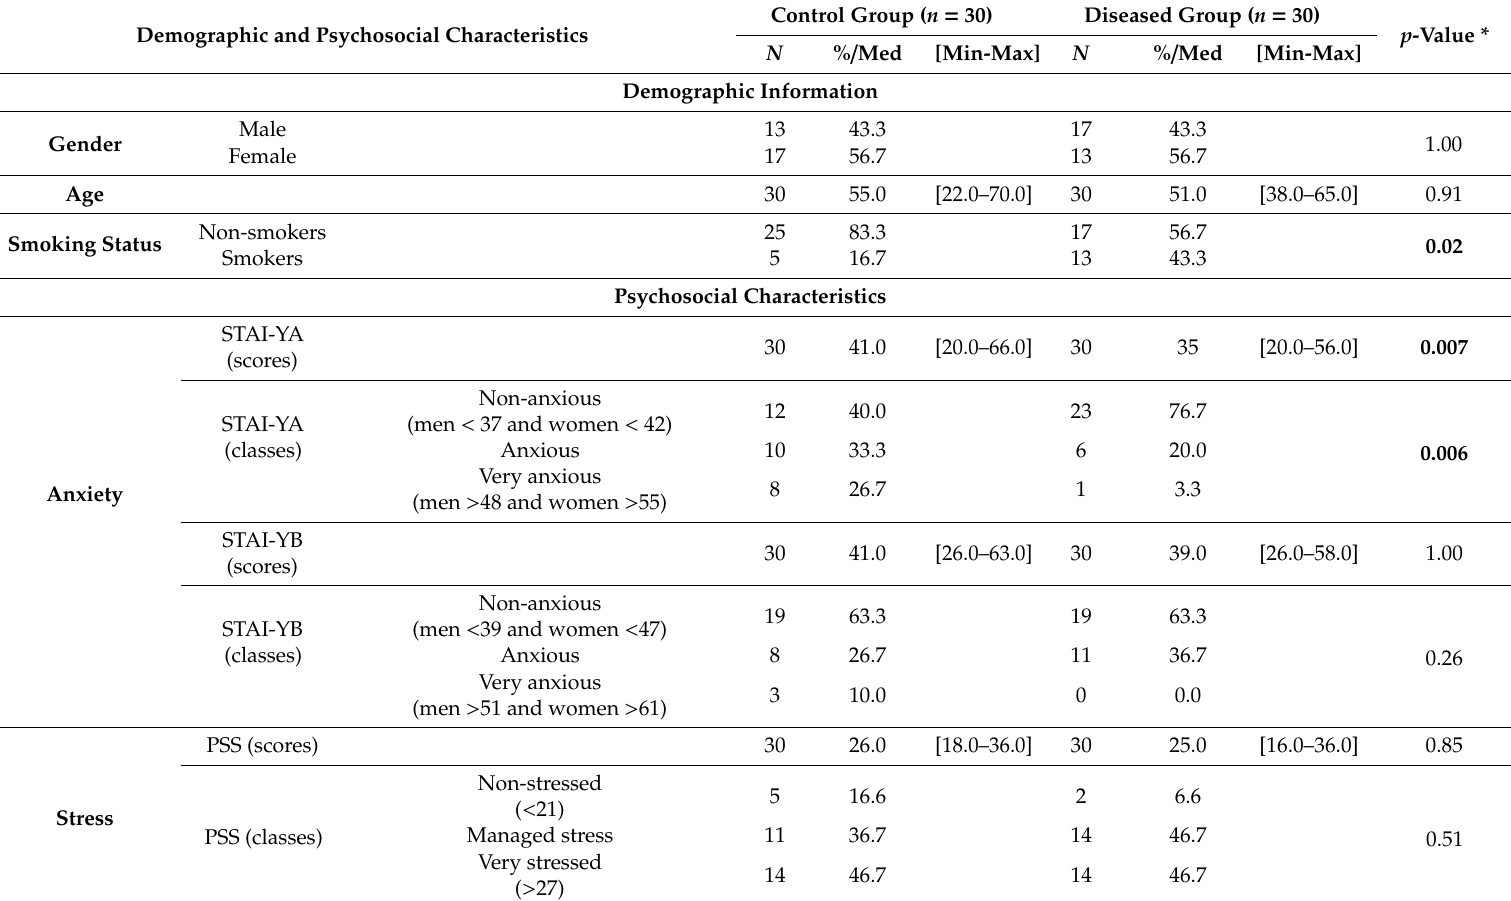
Table 1. Demographic and psychosocial characteristics of the study